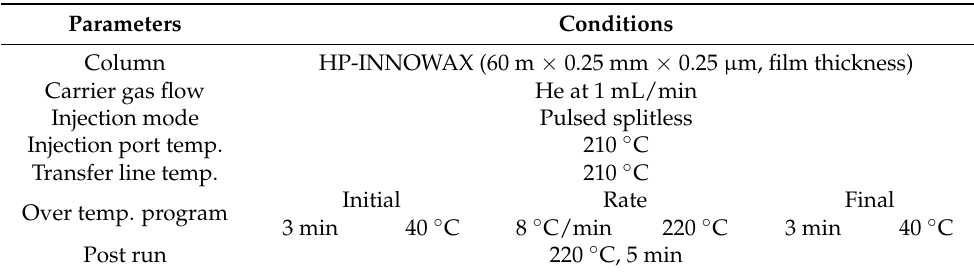
Table 2. Conditions for the operating parameters for NVOC